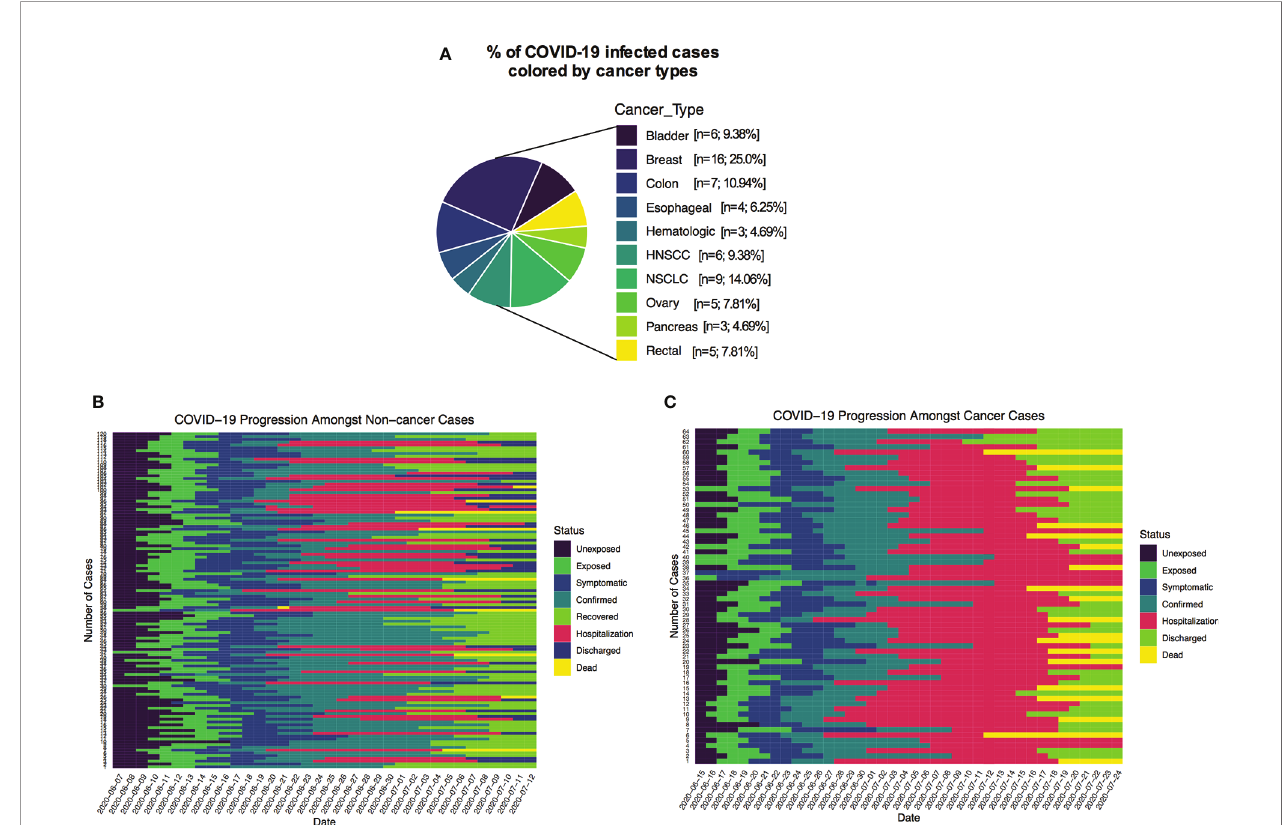
FIGURE 2 | (A) Percentage of COVID-19 positive cancer cases colored by cancer types. (B, C) Disease timelines: date at which cases is unexposed, exposed, symptomatic, date of con fi rmed, recovered, date of hospitalization, discharged and deaths of cancer and non-cancer COVID-19